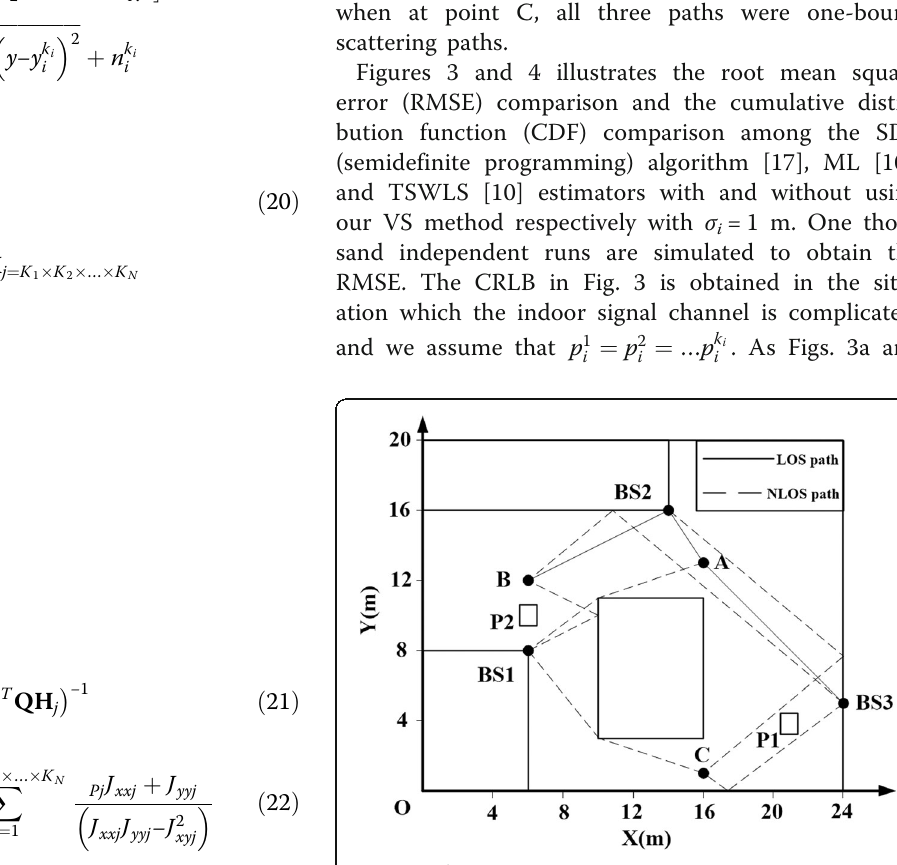
Fig. 2 Simulation